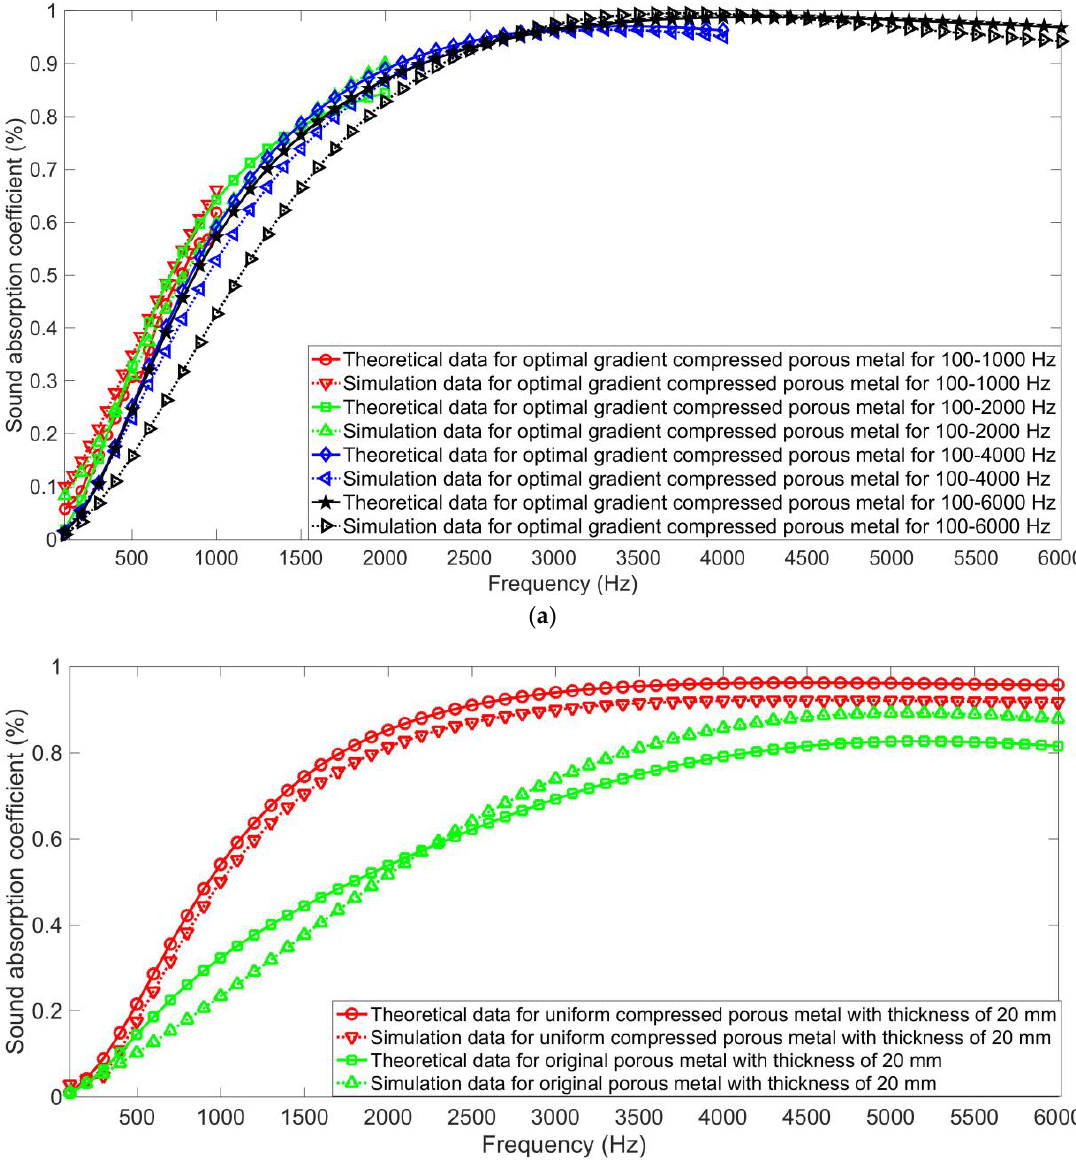
Figure 4. Comparisons of the sound absorption coefficients in theory and those in simulation. ( a ) The optimal 10-layer gradient compressed porous metals for the varied frequency ranges; ( b ) the original porous metal and uniform compressed porous metal with same thicknesses of 20 mm.